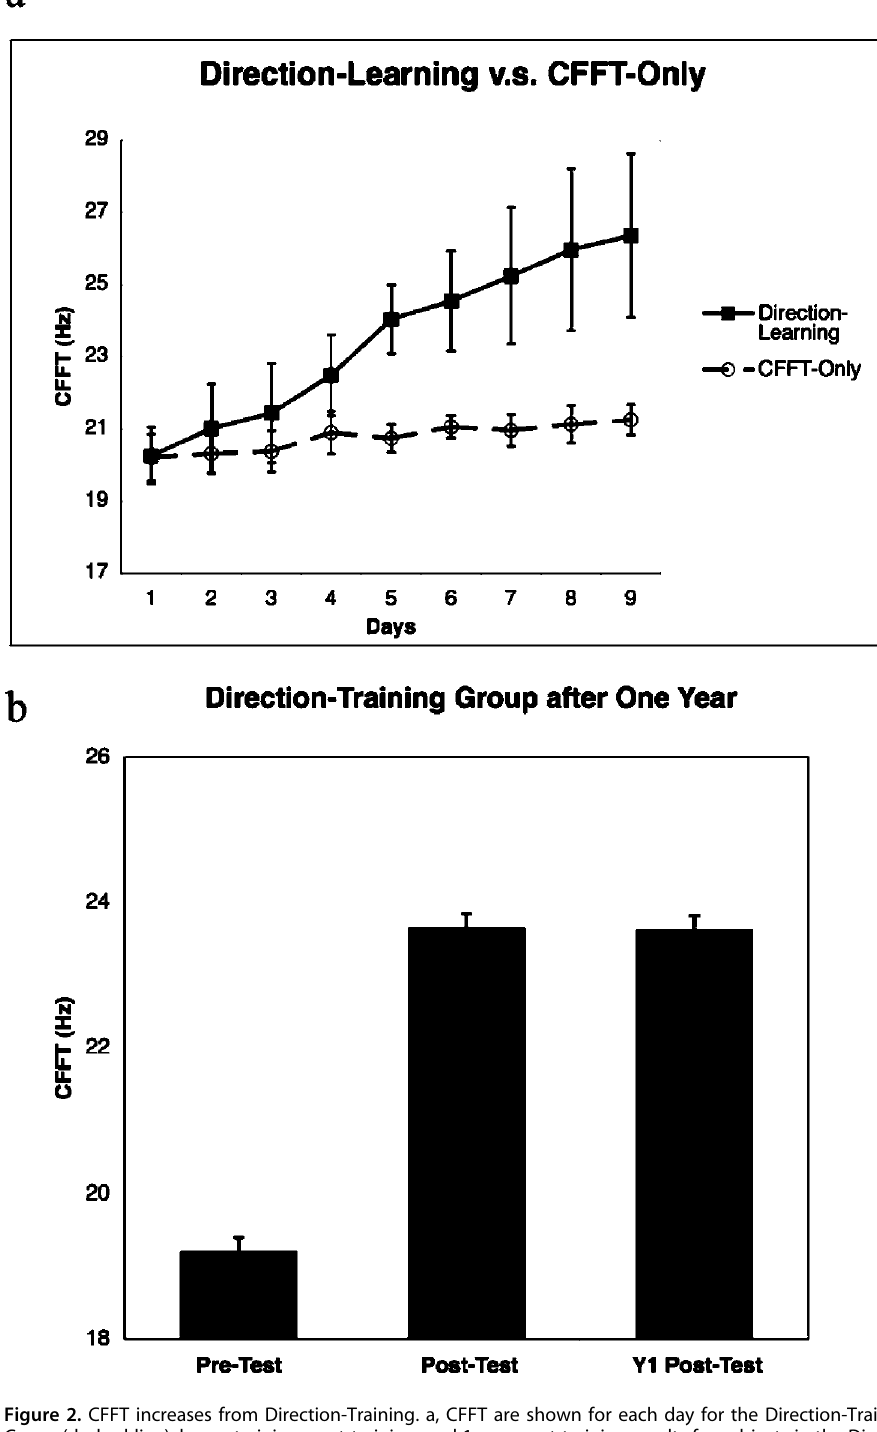
Figure 2. CFFT increases from Direction-Training. a, CFFT are shown for each day for the Direction-Training Group (solid-line) and the Flicker-Only Group (dashed-line). b, pre-training, post-training, and 1-year post-training results for subjects in the Direction-Training group who were re-tested 1- year after the conclusion of the training procedure. Error bars reflect standard-error.